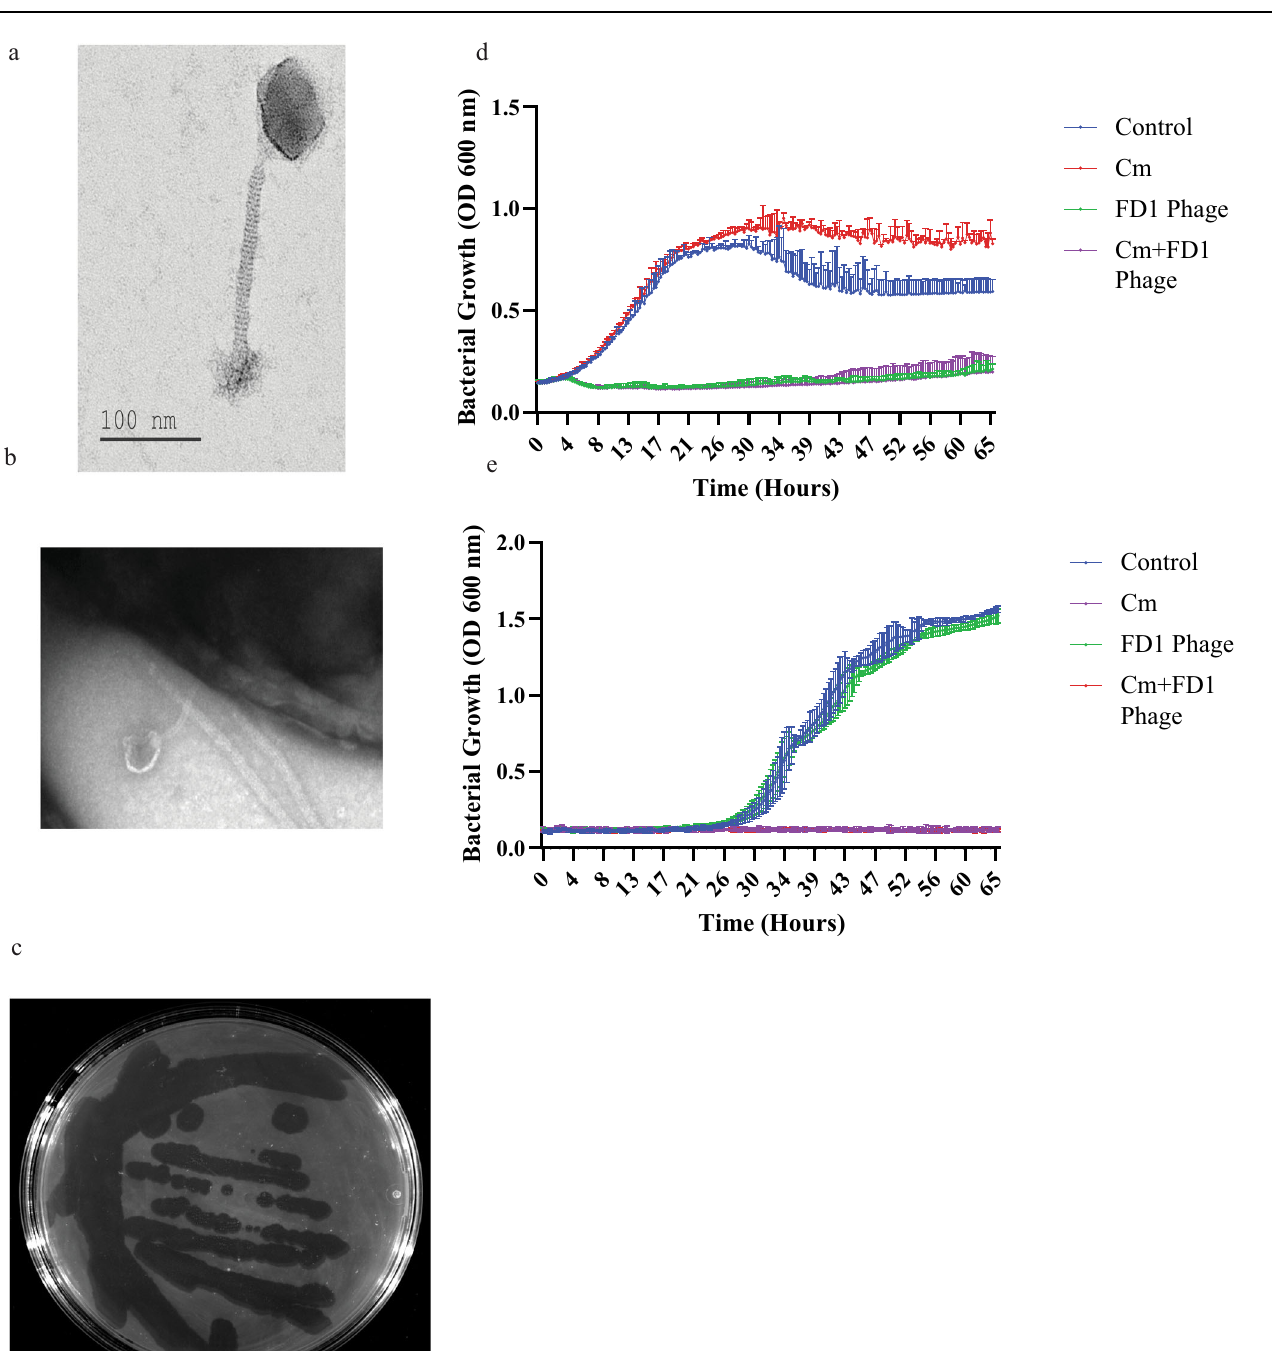
28, growth with CM, phage FD1, and combination. The results are the average of triplicates, presented as mean±standard deviation (SD). e FD1-resistant strain 21 growth with CM,FD1phage, and theircombination. The twolowercurves, CM and CM+FD1, overlap. The results are the average of triplicates, presented as mean± SD. CM, clindamycin. Source data are provided as a Source Data fi